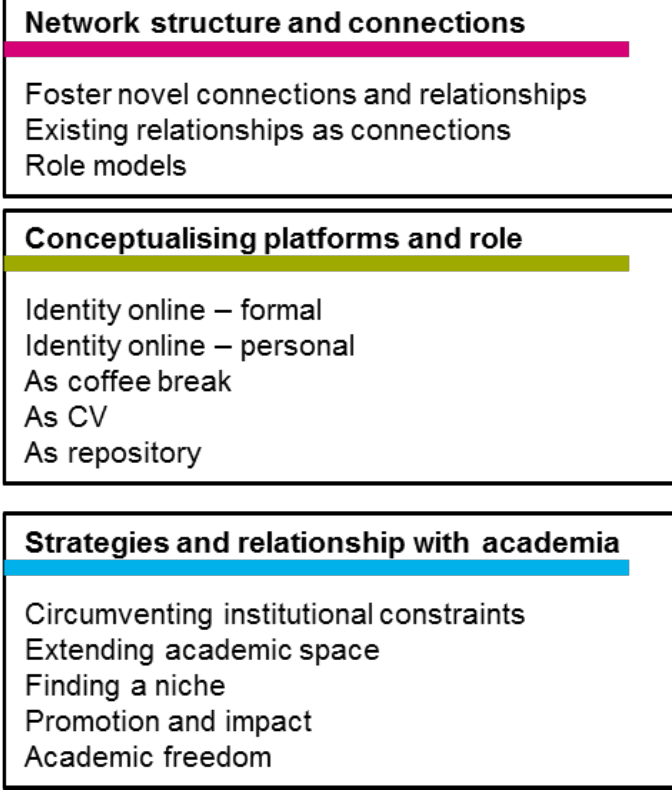
Figure 2. Emergent themes from the qualitative